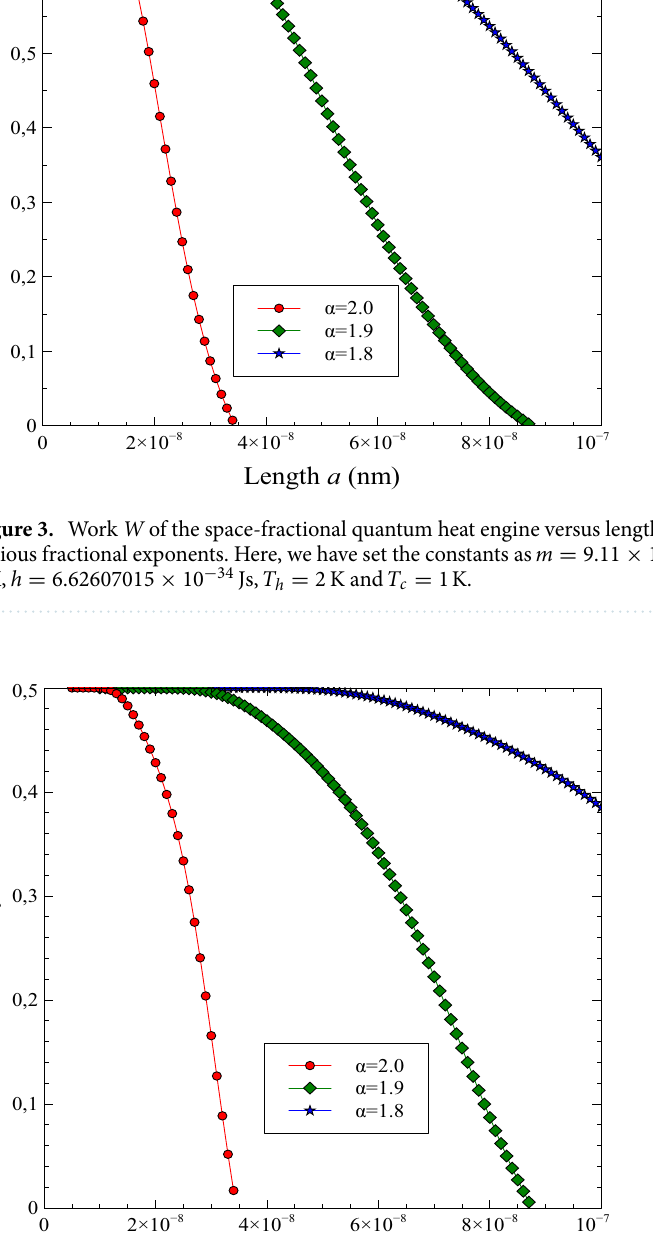
Figure 4. Efficiency η of the space-fractional quantum heat engine versus length a (in nano-meters) for the various fractional exponents. Here, we have set the constants as m